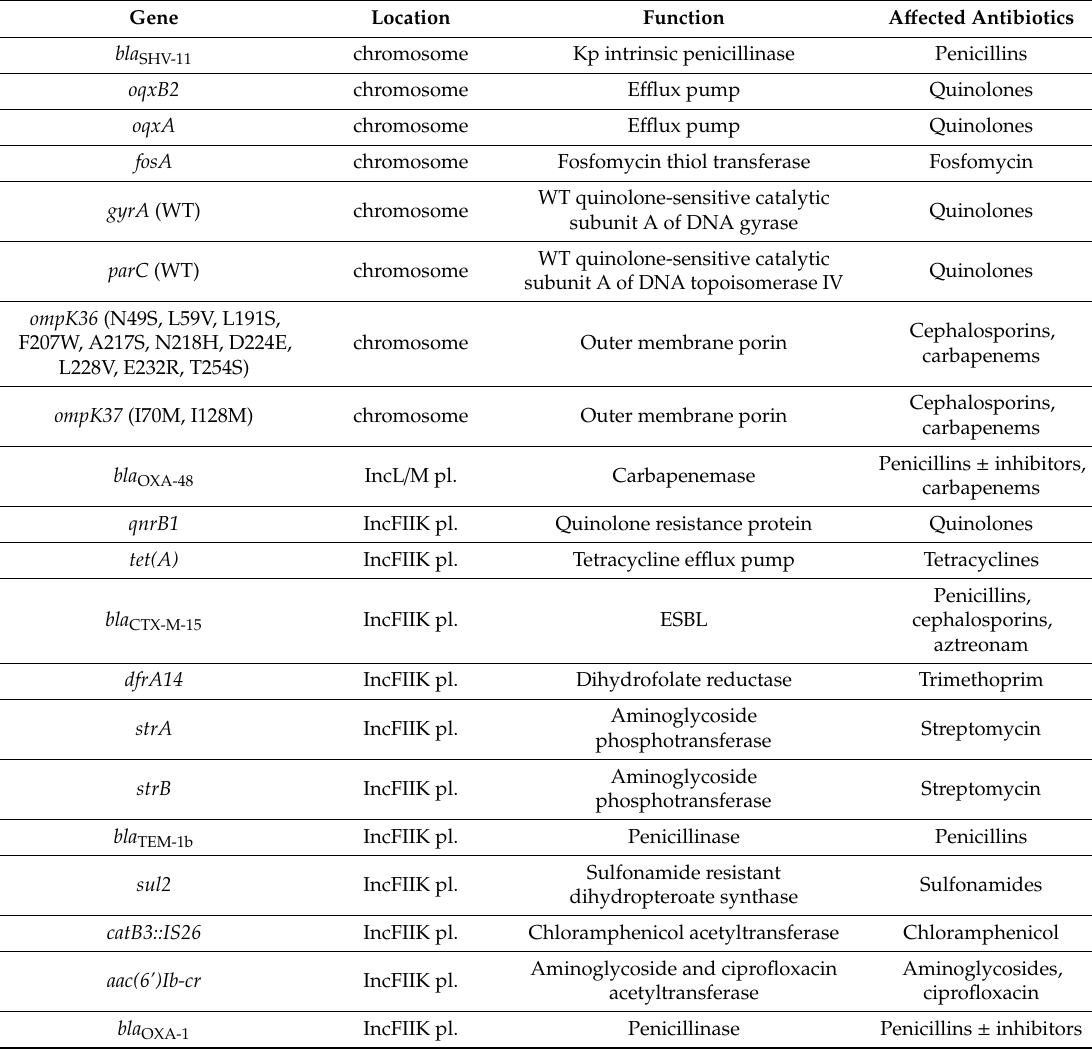
Table 2. Antibiotic resistance genotype of MAR14-456.